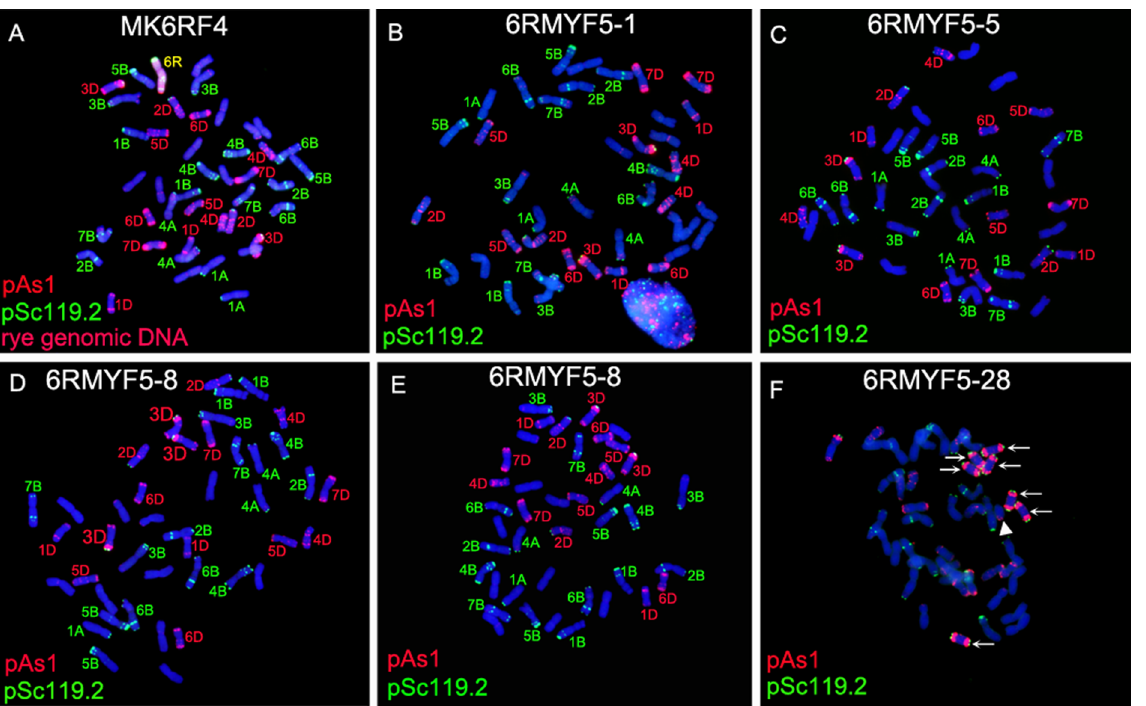
Figure 4. FISH and GISH using pAs1 (red), pSc119.2 (green) and rye genomic DNA (red) as probes on 6R monosomic addition line and its selfed progeny. A FISH and GISH analyses on the chromosomes of MK6RF 4 . B One 4B chromosome is eliminated in wheat line 6RMYF 5 -1. C Both of the 4B chromosomes are eliminated in wheat line 6RMYF 5 -5. D Three 3D chromosomes are observed and one 1A chromosome is eliminated in wheat line 6RMYF 5 -8. E One 1A chromosome is eliminated in wheat line 6RMYF 5 -8. F Seven 3DS isochromosomes and a broken D-genome chromosome are observed in wheat line 6RMYF 5 -28. Arrows indicate the 3DS isochromosomes. Triangle indicates the broken D-genome chromosome. No GISH signals were observed in B, C, D, E and F. Chromosomes were counterstained with DAPI (blue).